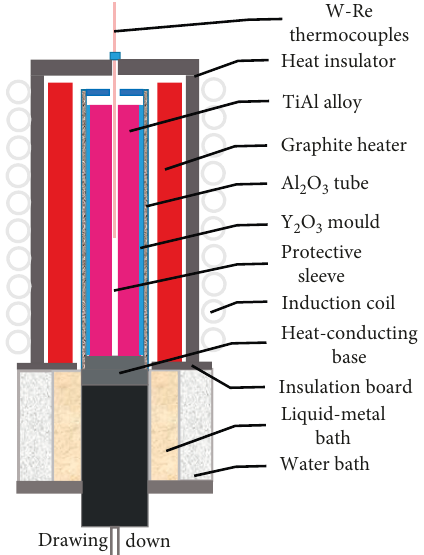
Figure 1: Schematic diagram of the modified Bridgman-type